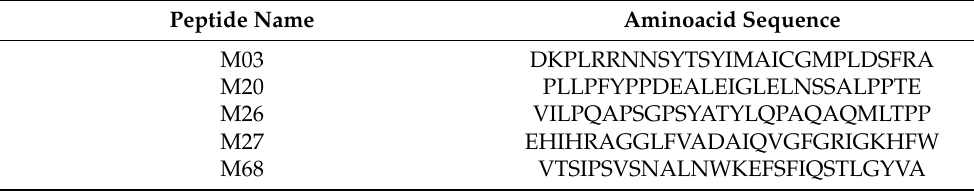
Table 1. List of the synthetic peptides with the corresponding amino acid